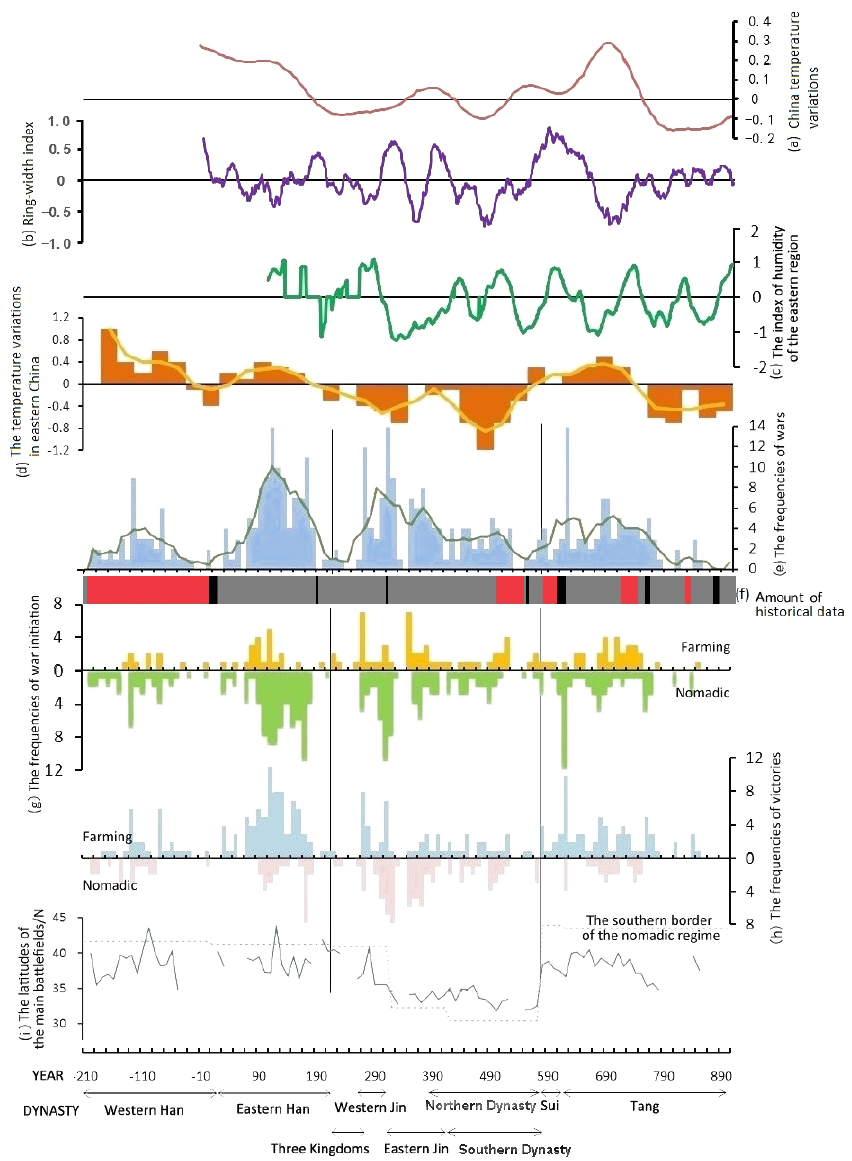
Figure 2. Sequence of wars between the northern nomadic and farming groups. Panel (a) : China temperature variations during AD1–910. Ensemble temperature reconstructions based on partial least squares (PLS) methods at centennial timescales (smoothed by a 5-point fast Fourier transform (FFT) filter) (Ge et al., 2013); panel (b) : ring-width index with 31-year moving averages from the northeastern Qinghai– Tibetan Plateau (Shao et al., 2010); panel (c) : annual humidity index of China from AD105 to 910 (smoothed by a 31-point FFT filter) (Zheng et al., 2006); panel (d) : temperature variations in eastern China and three-point moving average curve for winter half-years during 200BC–AD910 (30-year period timescale) (Ge et al., 2003, 2010); panel (e) : frequency of war and five-point moving average values (green solid line); panel (f) number of historical records – red indicates a rich phase in the historical data, grey indicates plentiful data, black regions indicate breaks in the data record (Zhang, 2002); panel (g) : frequency of wars initiated by the farming and nomadic groups; panel (h) : frequency of victories of farming and nomadic groups; panel (i) : latitude of the main battlefields (N, blue solid line), changes in the southern border of the nomadic region in each dynasty (green dotted lines) (Wang,